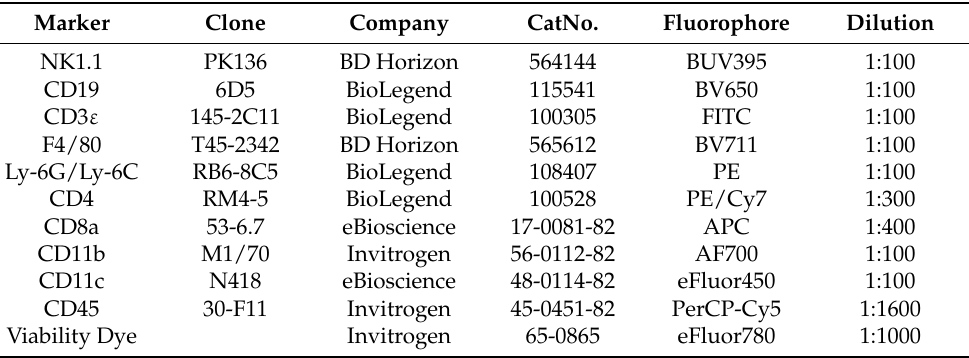
Table 1. List of monoclonal antibodies used in flow cytometry analysis of skin and spleen single cell suspensions to detect immune cell